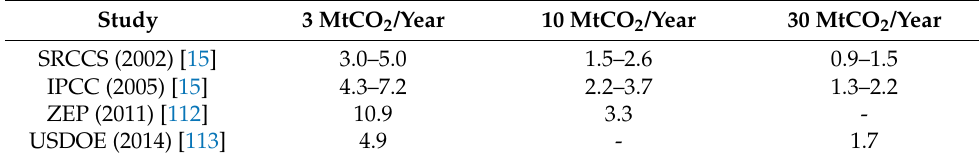
Table 11. Transport costs for onshore pipelines at three diverse capacities (adapted from [35]).